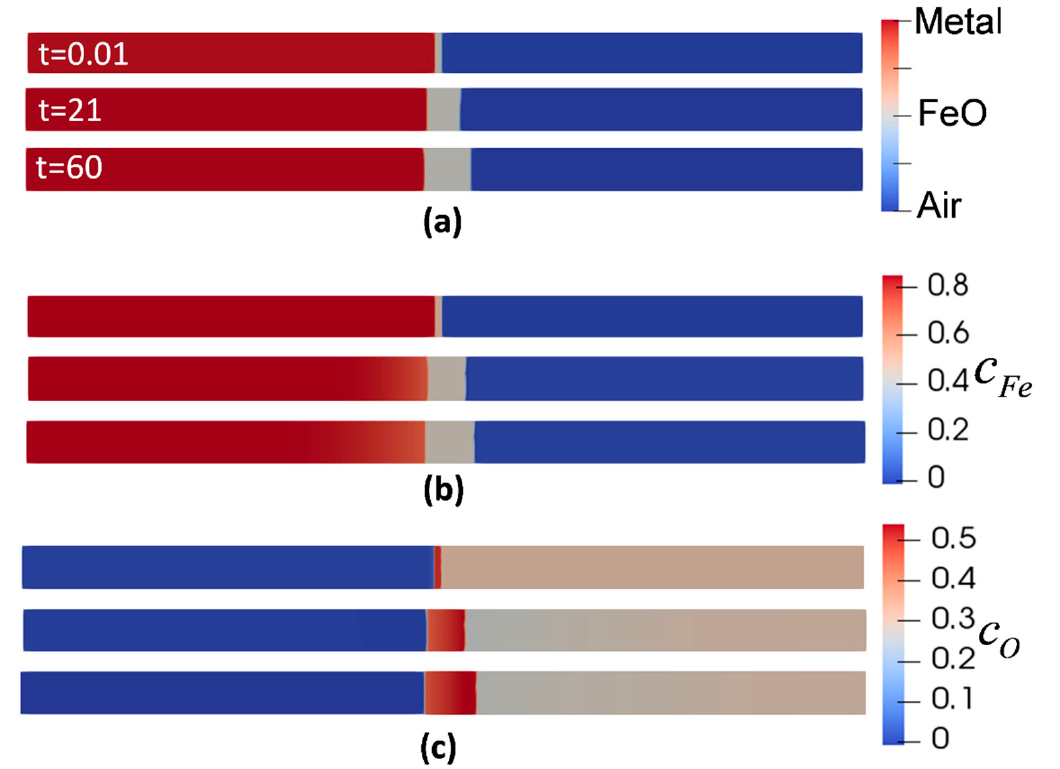
Figure 2. Evolution of phase-field (PF) variables during oxidation at temperature of 850 °C. ( a ) phases ( b ) concentration of Iron ( c ) concentration of oxygen.